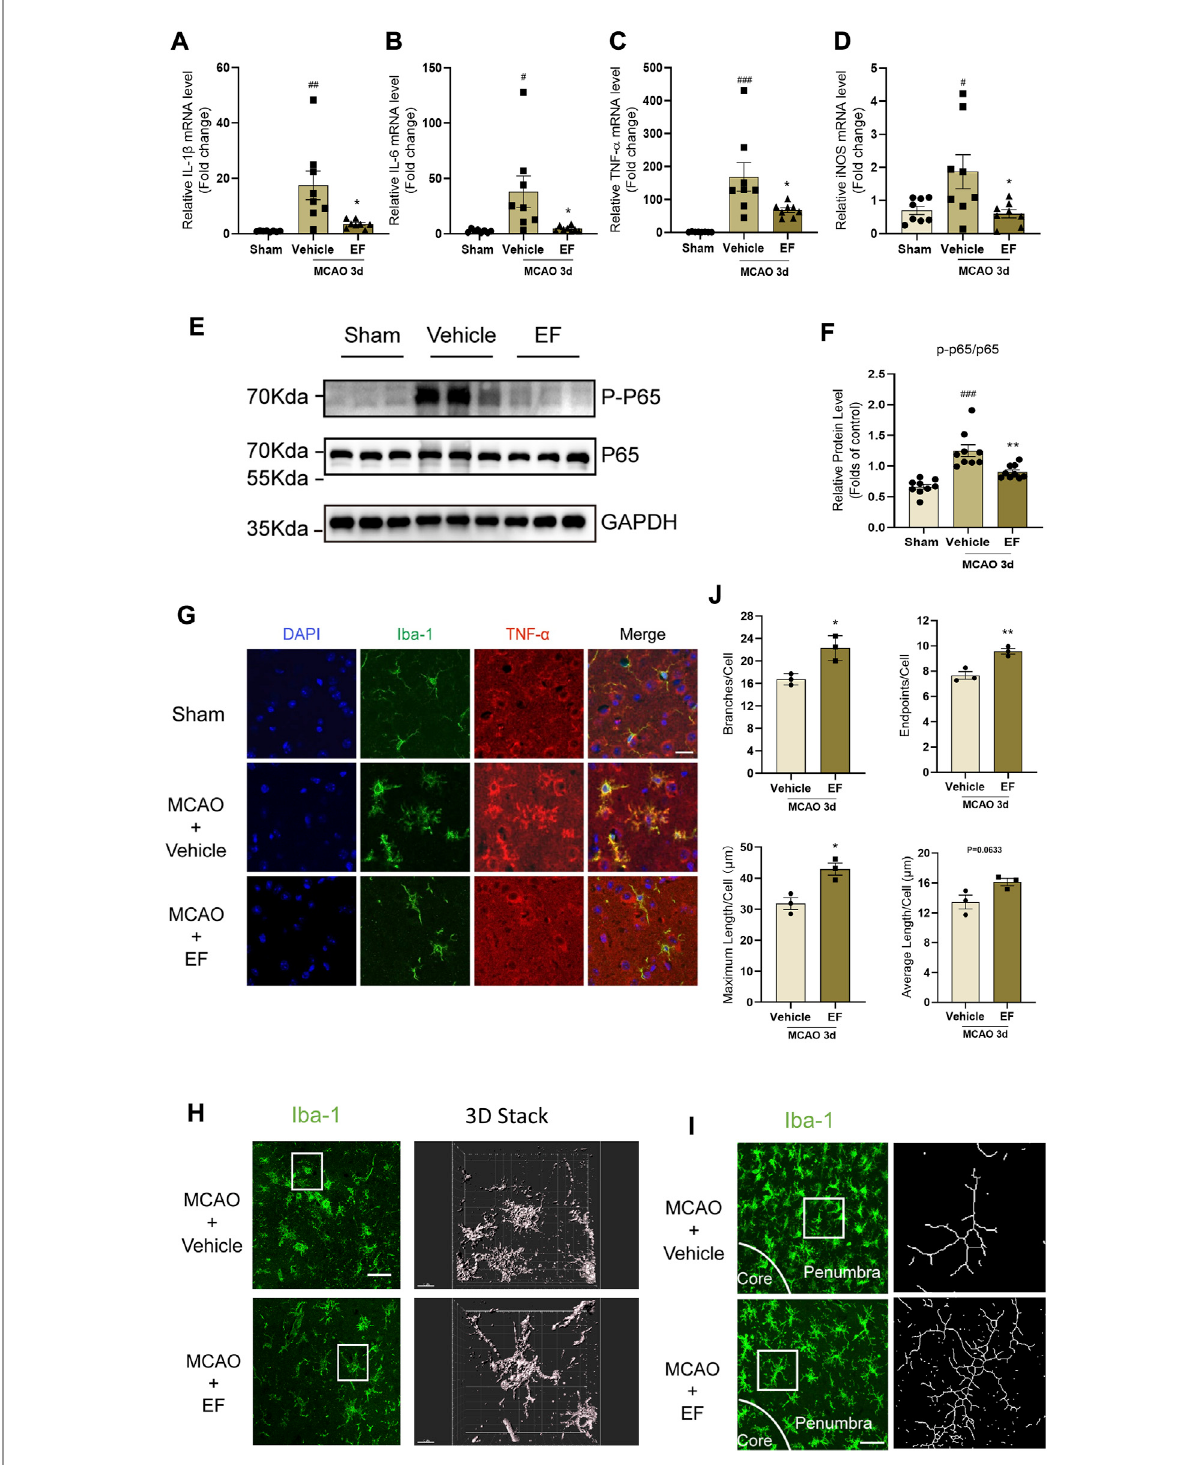
FIGURE 3 EFalleviates microglialactivation and post-stroke neuroin fl ammation after ischemia.Micesubjectedto tMCAO weredivided into three groups, the MCAO groups were administered with vehicle or EF via i.p. injection for 3 days. Then the ischemic penumbra of brain tissue from grouped mice was collected for RT-qPCR or western blot. (A – D) Total RNA of penumbra tissue was extracted and the mRNA levels of IL-1 β , IL-6, TNF- α and iNOS wereassessedbyRT-qPCR( n =8/group). (E,F) P-P65,P65andGAPDHproteinlevelsofhomogenatetissueweredetectedbywesternblot.The quanti fi cations of relative band intensities were determined by densitometry using ImageJ software ( n = 9/group). (G) Brain tissue slices